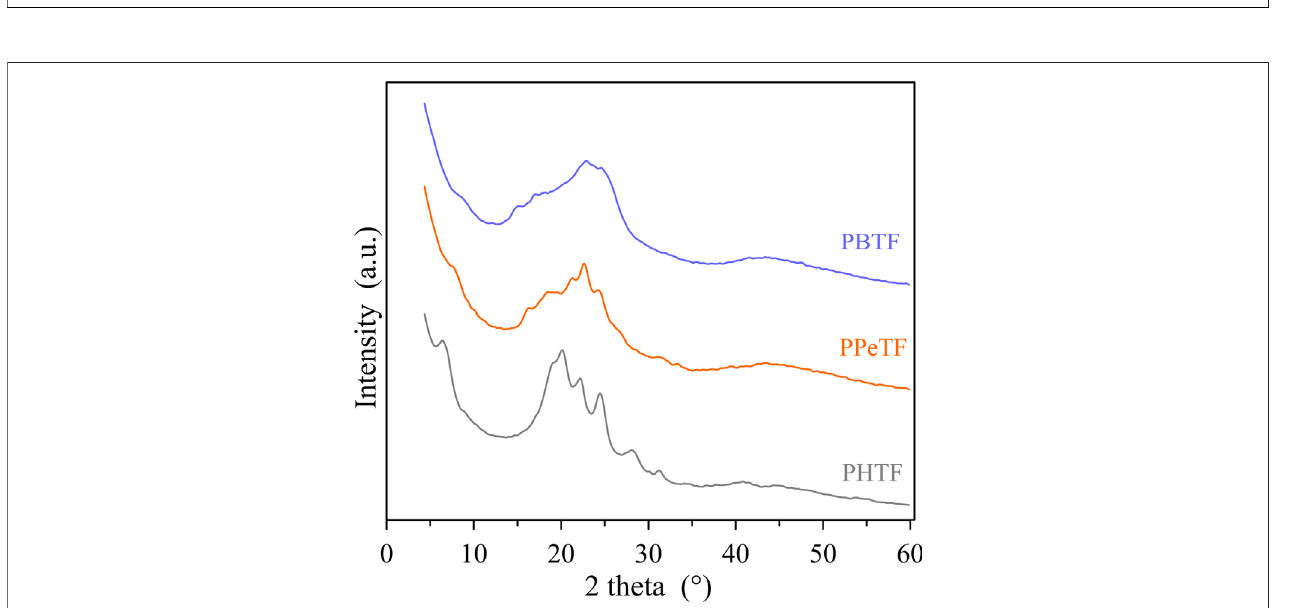
FIGURE 3 | XRD patterns of the investigated polyesters; interlayer distances of the main peaks are indicated in Angstrom.